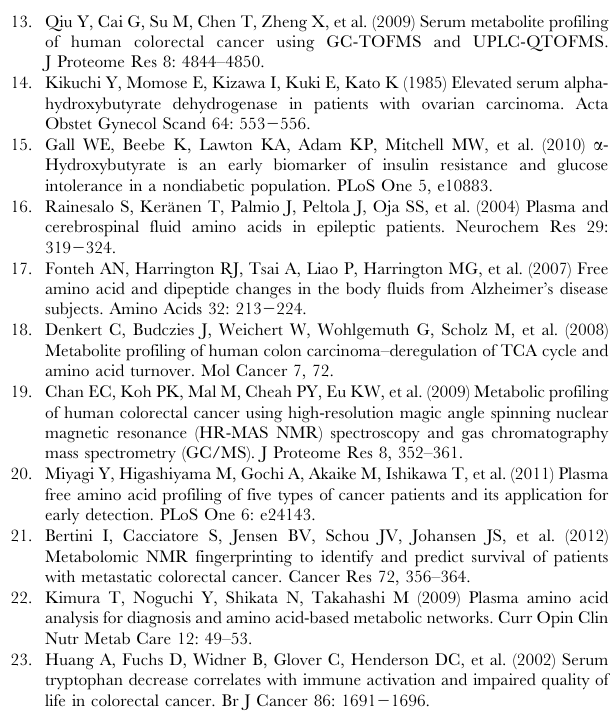
Figure S2 The associations between the sensitivity, specificity, and accuracy values of the training and validation sets. Regarding the 27 targeted metabolites, scatter plots of the sensitivity, specificity, and accuracy of the training and validation sets were produced, and then the associations between the training and validation sets were evaluated. The coefficients of correlation for the sensitivity, specificity, and accuracy values of the two sets were 0.425, 0.655, and 0.587, respectively. Figure S3 The inter-day and intra-day variances of tryptophan. The inter-day and intra-day variances of the serum levels of tryptophan were evaluated. To confirm the intra-day variance, blood was collected before breakfast (A), before lunch (B), and before dinner (C). For the inter-day variance, blood was collected before breakfast for a total of 3 days (Day 1, Day 2, and Day 3). The data are shown as mean 6 standard deviation values (N = 16). Asterisks indicate the significant differences by the Wilcoxon signed-rank test and/ or Steel-Dwass test (p , 0.05). Table S1 Subject information for the training set. Table S2 Subject information for the validation set.